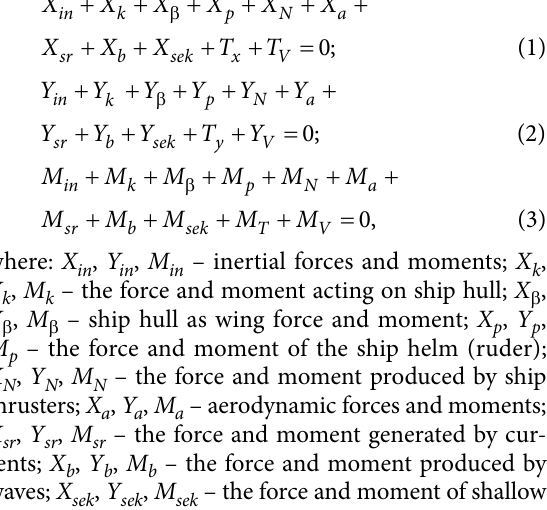
Fig. 2 . Jetties at the oil terminal in the Port of Kalundborg (Denmark)